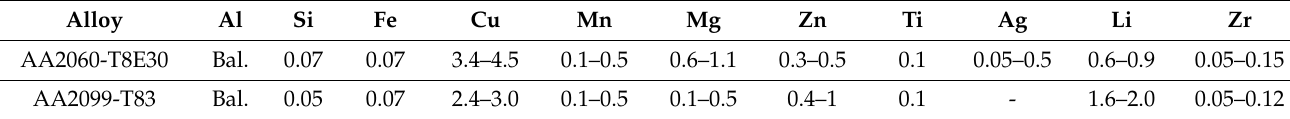
Table 1. Chemical composition of base materials, wt %.